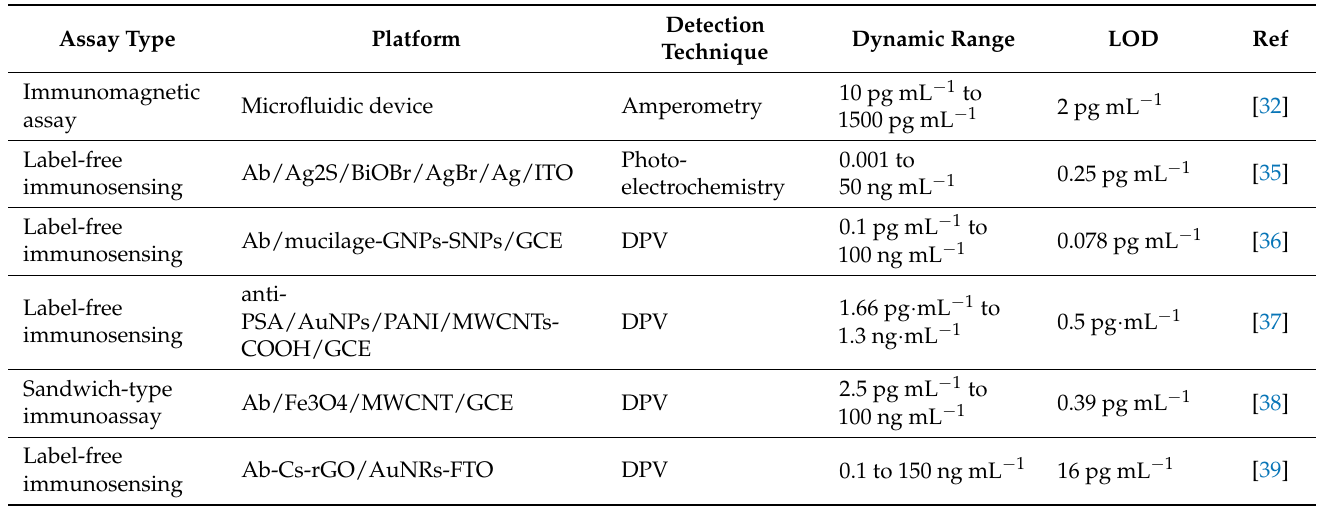
Table 3. Comparison of main analytical features of different immunosensors for PSA serum sample determination reported in the